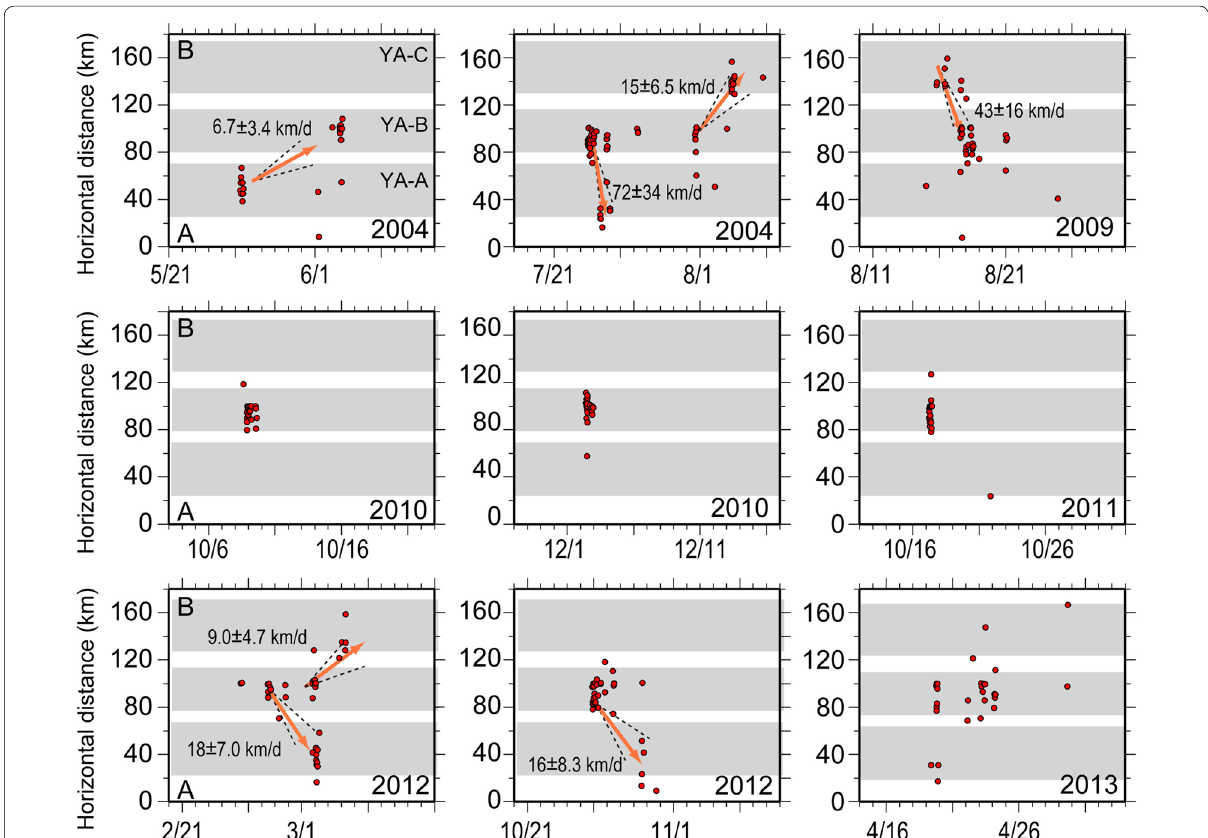
Fig. 10 Time–space plot of low-frequency earthquake (LFE) swarm in the Yaeyama area. The swarm is plotted when the number of events was >18. The plotted area and annotations of A and B are denoted in Fig. 6a. Red circles show the LFEs. Arrows and dotted lines show the direction of LFE migration and its error range, respectively. Gray hatched areas show clusters YA-A, YA-B, and